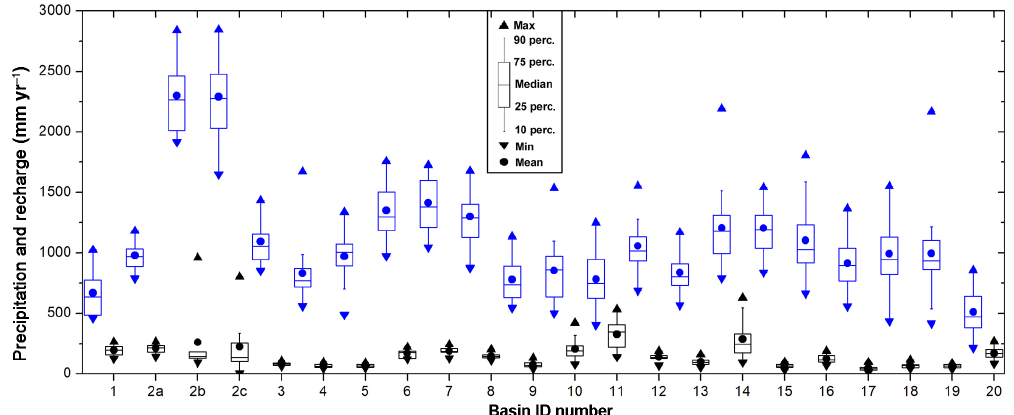
Figure 9. Basin-wide box-whisker plot of precipitation (blue) and recharge rates (black). Symbols representing the mean, median, maximum value (max), minimum value (min), 10th percentile, 25th percentile, 75th percentile and 90th percentile are shown in inset of the bottom